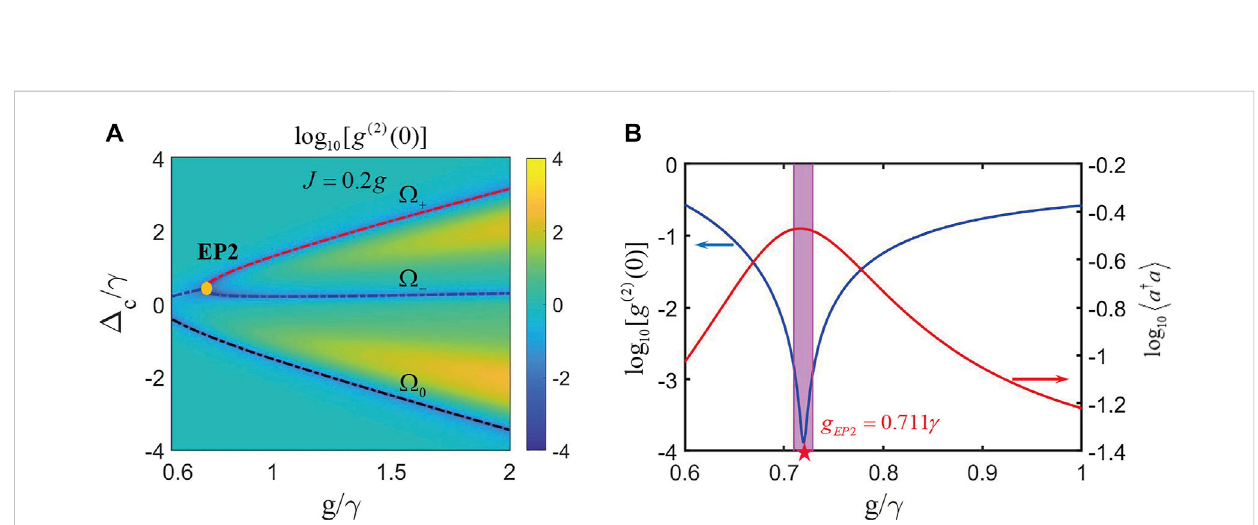
FIGURE 14 In the pseudo-Hermitian conditions when g 1 (cid:1) g 2 (cid:1) g and J (cid:1) 0 . 2 g , there is also an EP2 in the system. (A) Plots of g ( 2 ) ( 0 ) versus the normalized detuning Δ c / γ and the coupling strength g / γ . In (B) , the strong PB effect is shown at g EP 2 / γ (cid:1) 0 . 711. We choose detuning as Δ c / γ (cid:1) 0 . 417 , and other parameters are same as those in Figure